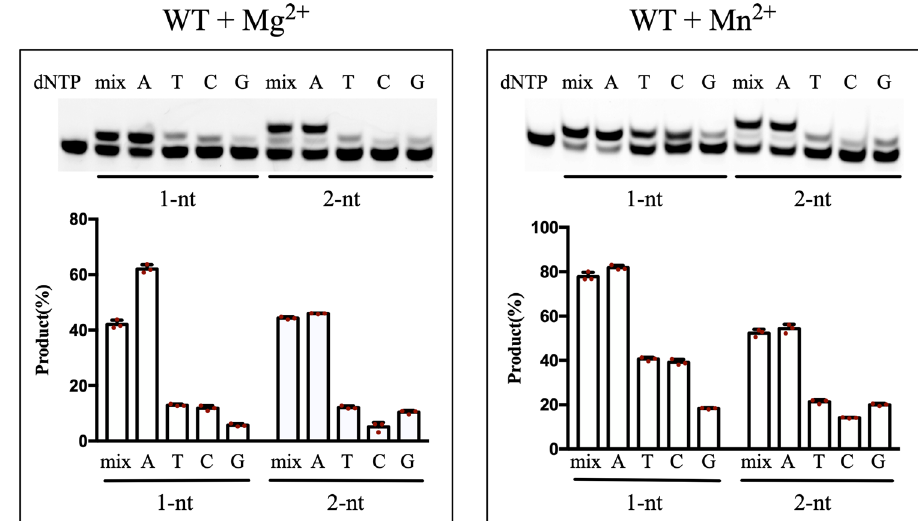
Fig. 1 Base selection and ef fi ciency of Pol μ incorporation opposite gapped DNA containing one (1 nt) or two (2 nt) templating T in the presence of either Mg 2 + or Mn 2 + . Reactions were carried out at a substrate:enzyme molar ratio of 50:1, with a single type or a mixture of all four dNTPs at a total concentration of 0.4 mM at 37 °C for 7 min as described in the “ Method ” section. A plot of quanti fi cation of product formation is shown below the gel (data are presented as mean ± s.e.m, n = 3 biologically independent